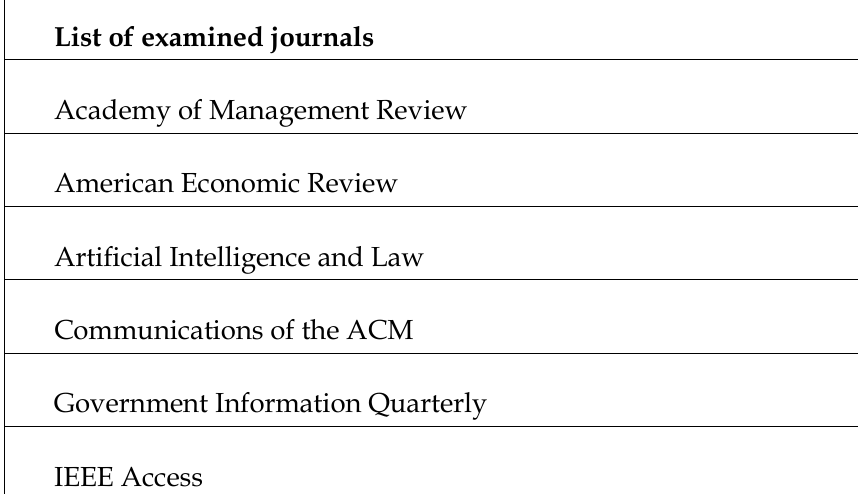
Table 1: List of all the examined journals. The list is ordered alphabetically. List of examined